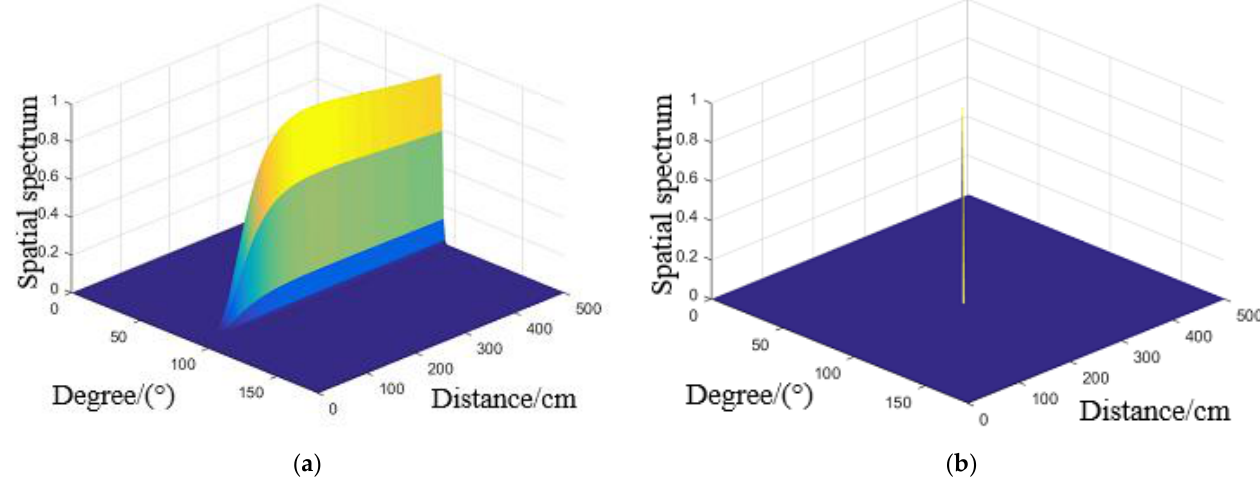
Figure 12. Spatial spectrum estimated for 50 ◦ C by ( a ) Stander 2D-MUSIC ( b ) Compensated